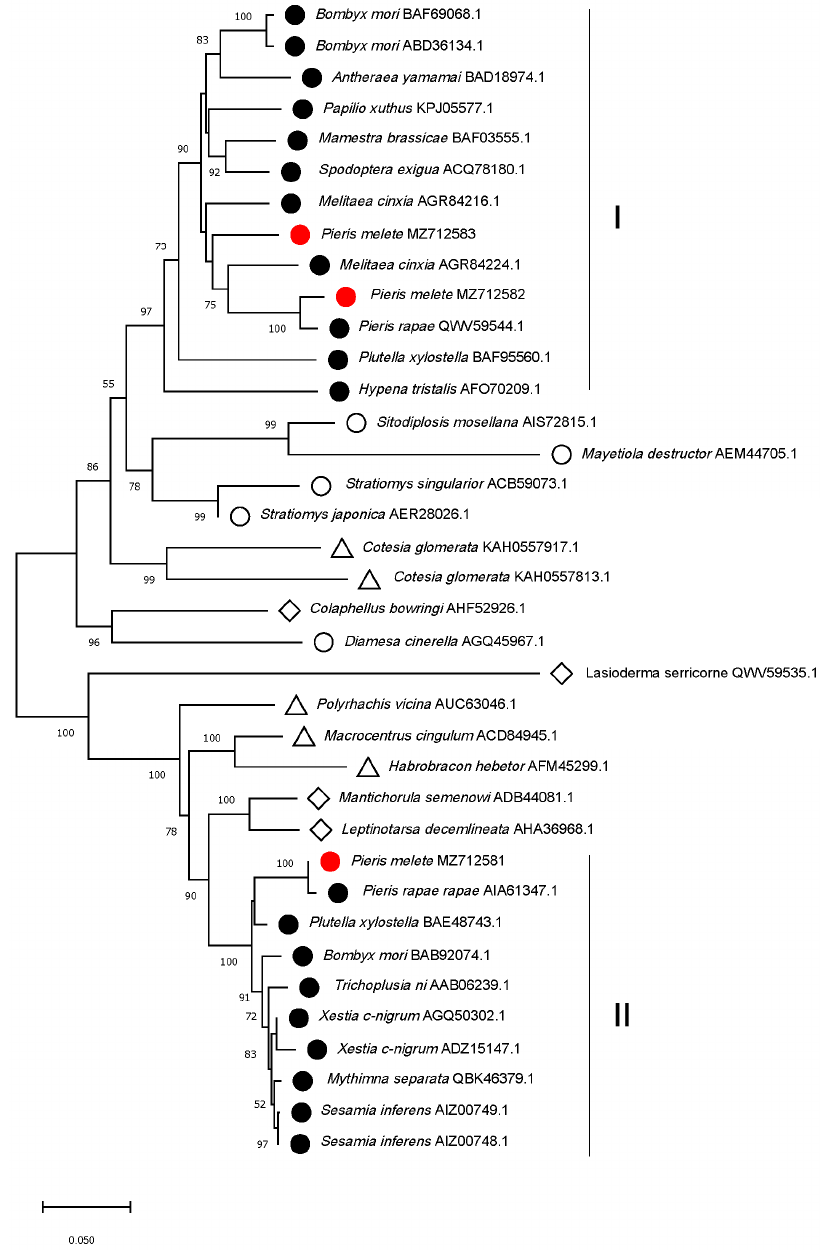
Figure 2. Phylogenetic neighbor-joining tree of PmHSC70, PmHSP70a, and PmHSP70b of Pieris melete and other insect HSPs using Mega X. The percentage bootstrap values obtained by 1000 repeated calculations were displayed at the nodes, and percentage values lower than 50% were collapsed. The PmHSC70, PmHSP70a, and PmHSP70b in our study were marked with a red solid circle. Lepidoptera, Coleoptera, Diptera, and Hymenoptera HSP70s from previous studies were labeled with a black solid circle, hollow rhombus, hollow circle, and hollow triangle,